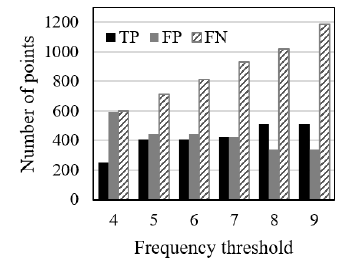
Figure 5. Effect of frequency threshold on CH filter, using square cells of 50 m and bin width of 15